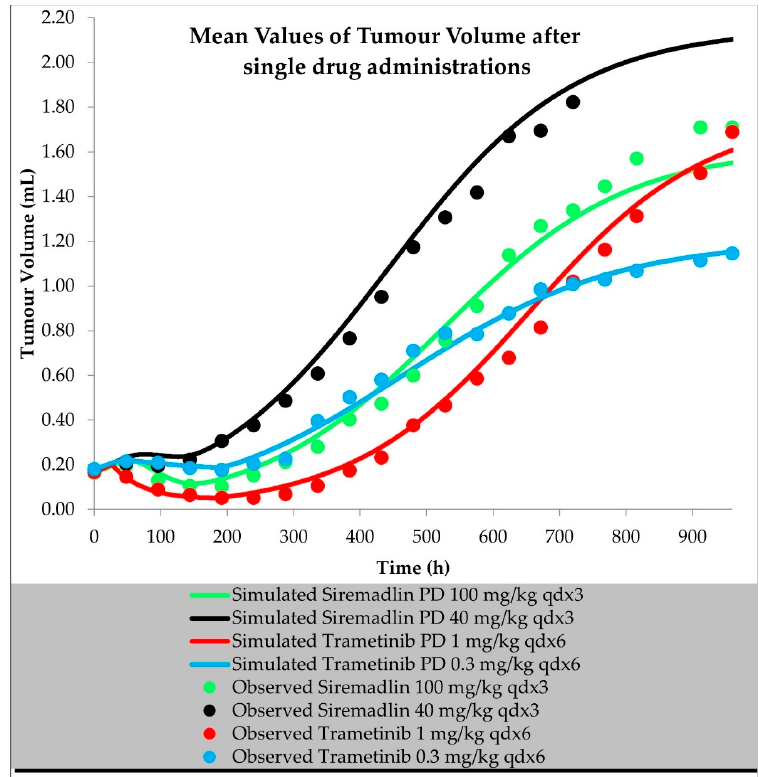
Figure 8. Tumour volume simulations after single drug administration of siremadlin and trametinib. Observed data are means from n = 6. To properly fit the tumour volume data, TGI modelling for drug combinations required additional parameters for the drug interactions at the PK and PD levels. We tested two different parameters that were determined to be drug interaction parameters at the PD level during the in vitro data analysis (Table S1). We selected the β parameter from the MuSyC drug interaction model as the translational in vitro/in vivo PD parameter. We predicted that the interactions at the PK level (the AUC ratio parameters for siremadlin and trametinib) would be dose-dependent in all the tested drug combination